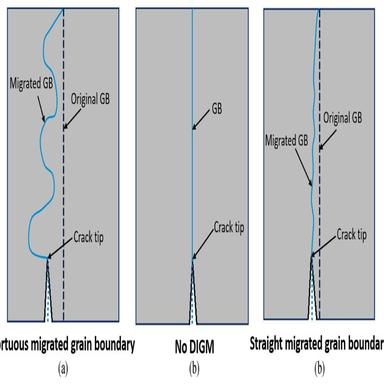
Schematic images showing the SCC crack growth along different types of GBs: (a) a tortuous migrated GB; (b) a GB without DIGM; (c) a straight migrated GB.